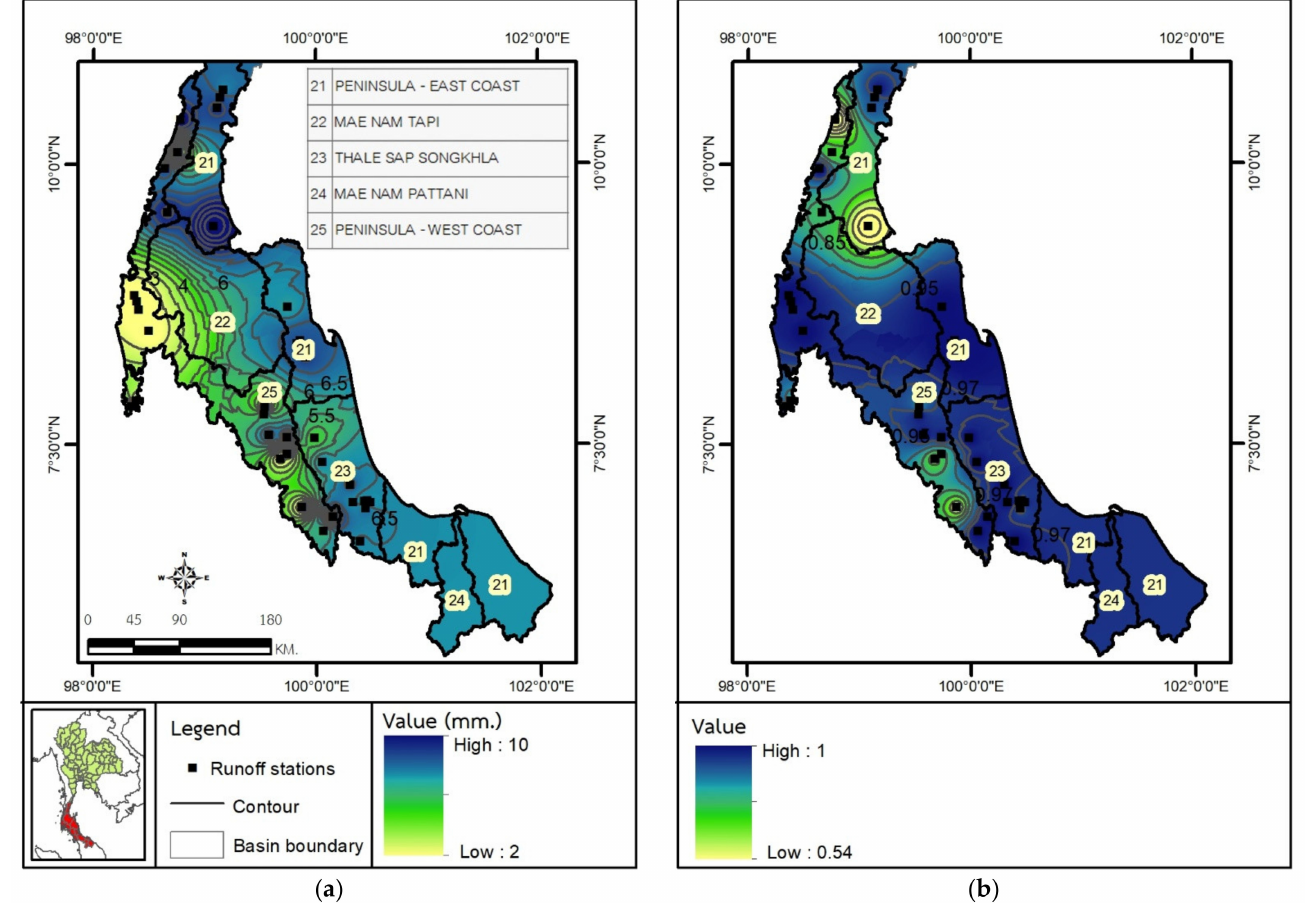
Figure 6. The spatial distribution of X 1 and X 2 values using IDW method: ( a ) Production Store: X 1 , and ( b ) Groundwater exchange rate: X 2